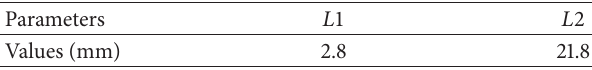
Table 1: Dimensions of the T-match (Figure